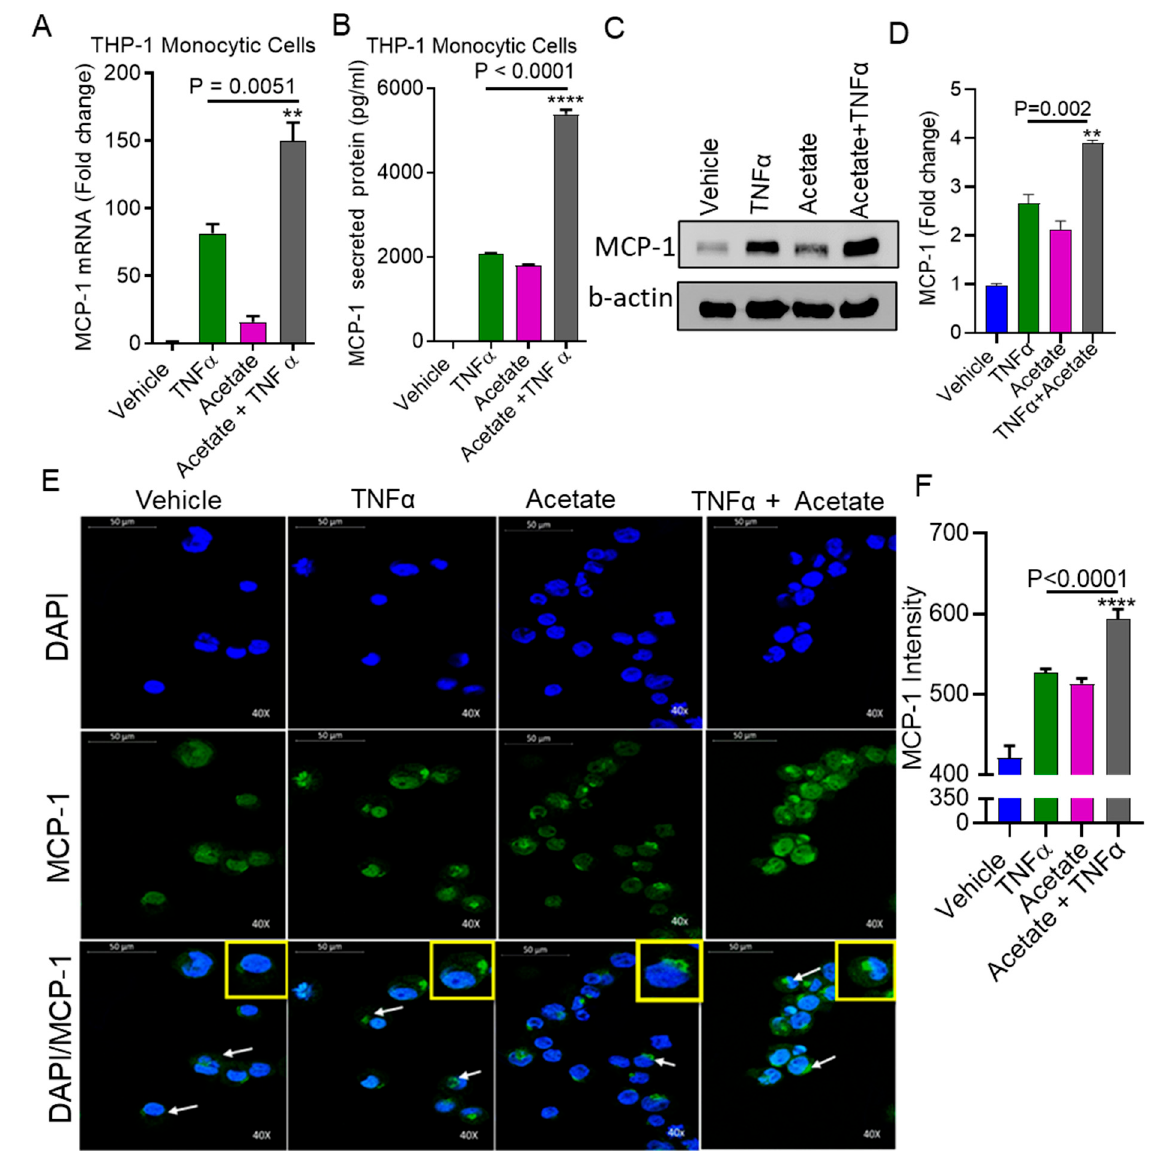
Figure 1. Acetate triggers TNF α induced MCP-1 expression in human monocytic cells. THP-1 monocytic cells were stimulated with acetate (100 mM) and TNF α (10 ng/mL) alone or in combination for 24 h. Cells and culture media were collected. ( A ) Total RNA was extracted from the cells and MCP-1 mRNA was quantified by real time PCR. Relative mRNA expression was expressed as a fold change. ( B ) Secreted MCP-1 protein in culture media was determined by ELISA. ( C ) Cells were treated as described earlier. 8 h before harvesting, cells were incubated with 1 uL/mL of Brefeldin A (Brefeldin A Solution (1000 × ); Invitrogen, Thermo Fisher Scientific, Waltham, MA, USA). MCP-1 was determined by Western blot. ( D ) Quantification of Western blot. ( E ) THP-1 cells were immune-stained for confocal microscopy, as described in Materials and Methods. MCP-1 expression is shown by green fluorescence (inset), whereas nuclei are stained blue with DAPI (original magnification × 40). ( F ) MCP-1 fluorescence intensity was determined for 10 random images. The results obtained from three independent experiments are shown. All data are expressed as mean ± SEM (n = 3). ** p < 0.01, **** p < 0.0001 versus TNF α alone.